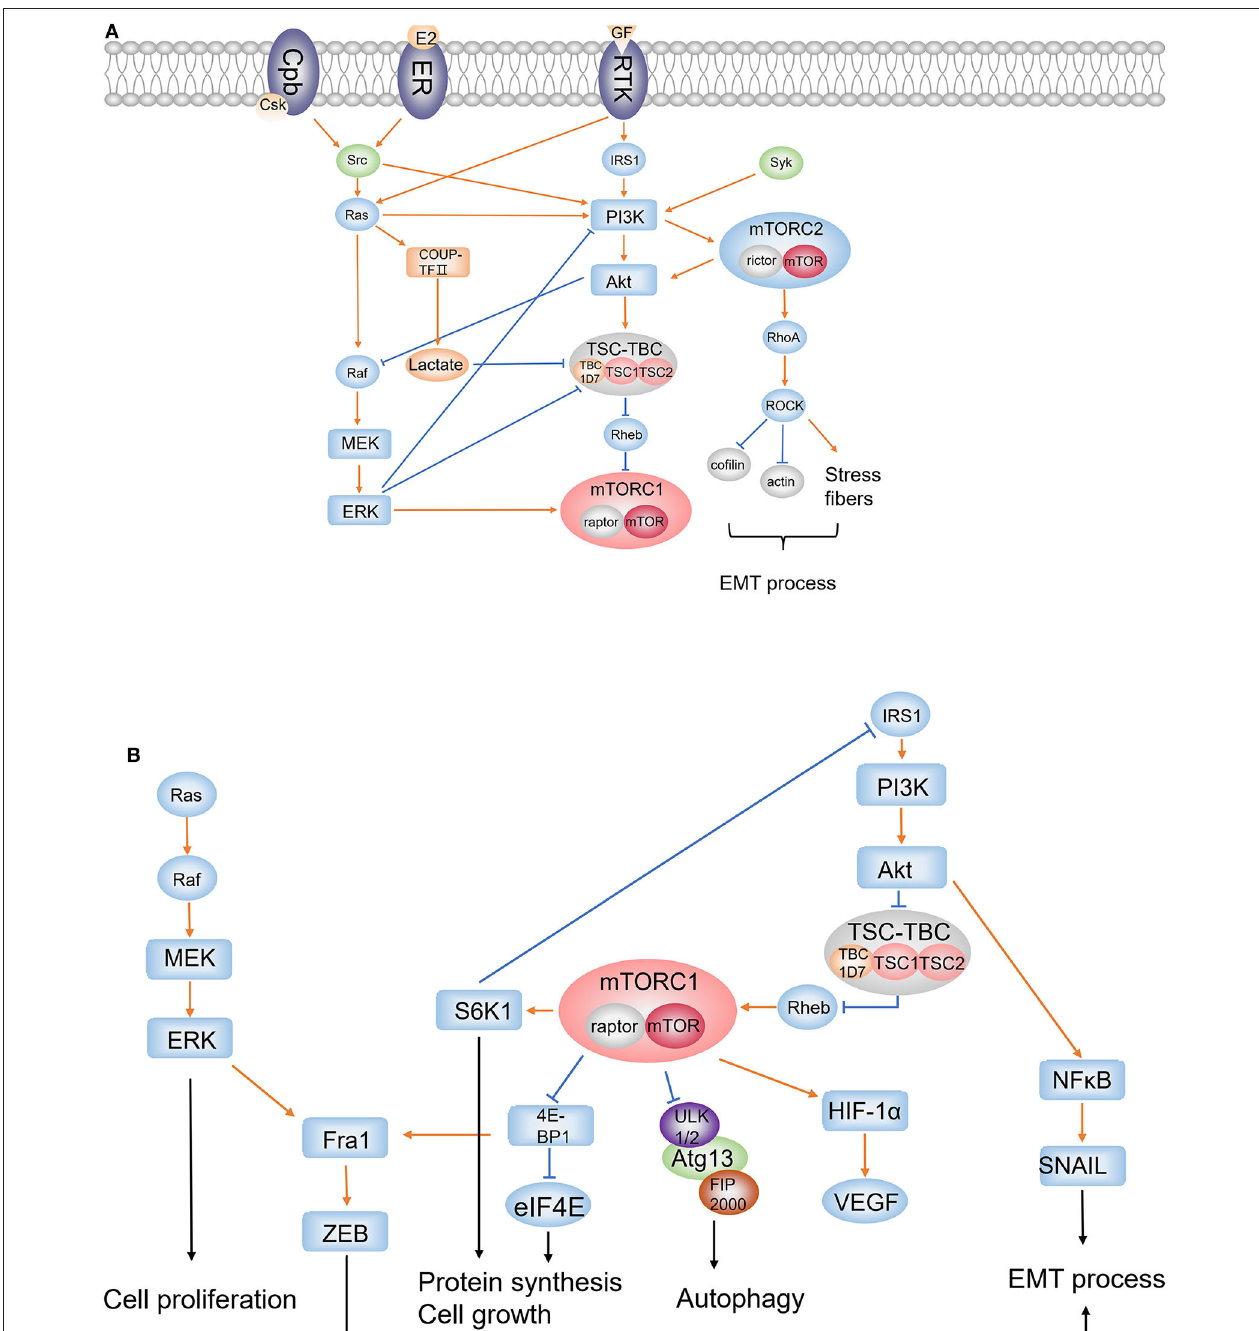
FIGURE 1 | PI3K/Akt/mTORC1 pathway, Ras/Raf/MEK/ERK pathway, mTORC2 signaling, and the EMT process. (A) Upstream regulators and accompanying pathways affecting mTORC1; (B) downstream effectors regulated by mTORC1. (1) mTORC1 and mTORC2: rictor and mTOR are components of mTORC2, whereas raptor is the binding protein of mTORC1. (2) RTKs: extracellular growth factors bind to RTK and activate IRS1 and Ras. (3) Src: Src is activated by ER or Csk; Src activates PI3K to regulate PI3K/Akt cascade and activates Ras to affect ERK pathway and PI3K/Akt cascade. (4) PI3K/Akt/mTORC1: the PI3K/Akt cascade is activated by IRS1, Src, Ras, and Syk; Akt suppresses TSC1/2 complex, which downregulates mTORC1 through Rheb, to upregulate mTORC1; mTORC1 phosphorylates S6K1 and 4E-BP1 to promote protein synthesis and cell growth, and phosphorylates ULK1 to inhibit autophagy; S6K1 inhibits IRS1 to form a feedback loop in PI3K/Akt/mTORC1 pathway. Activation of mTORC1 results in accumulation of HIF-1 α which increases the expression of VEGF. (5) Ras/Raf/MEK/ERK: Ras activates Raf; as a result, activated MEK1/2 upregulates ERK to affect cell proliferation. It is an important compensatory pathway of the PI3K/Akt/mTORC1 pathway. (6) The cross-regulation of Ras/Raf/MEK/ERK and PI3K/Akt/mTORC1: ERK inhibits PI3K and promotes mTORC1 directly or through